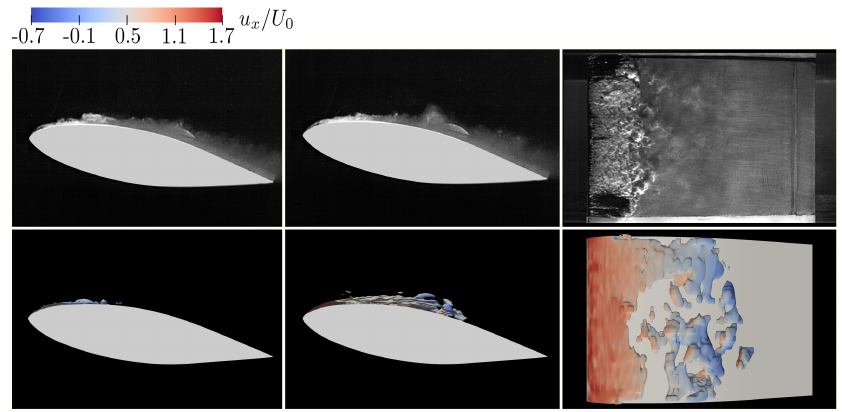
Figure 9. Similar to Figure 8 for regime II.